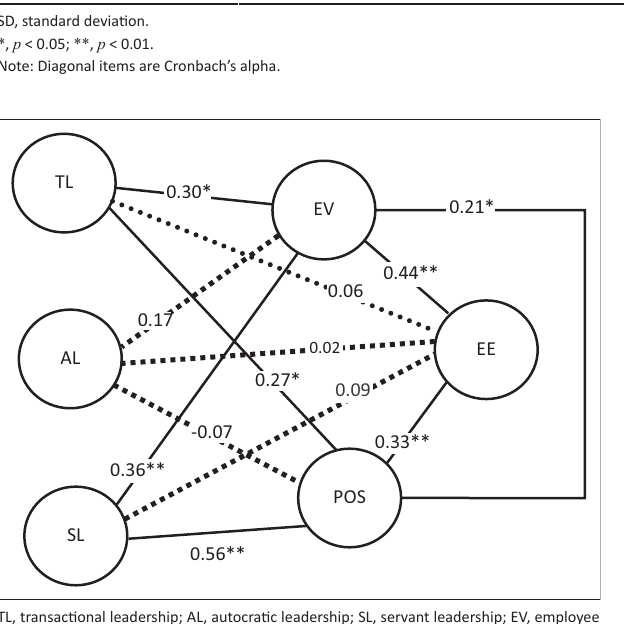
FIGURE 2: Estimated model.